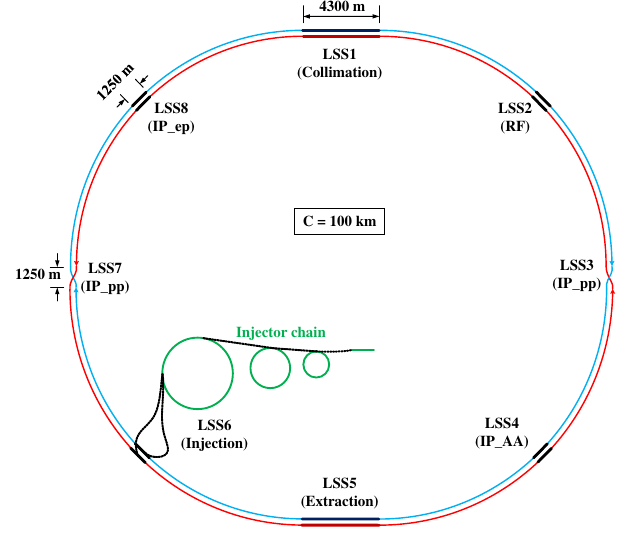
FIG. 18. The layout of the SPPC.